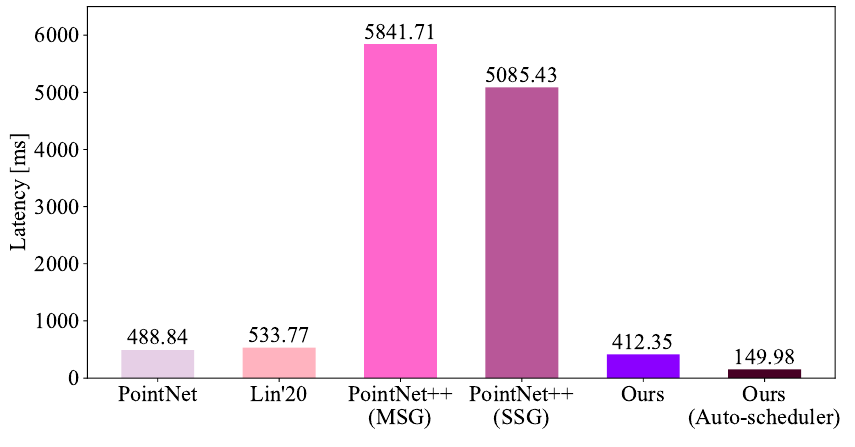
Figure 15. Comparison of latency on the UP Board CPU. Evaluating the latency under different tuning times: We present the latency of the optimized EffNet under different tuning times, as depicted in Figure 16. The latency changes with the number of trials on the UP Board CPU, Nano CPU, Nano GPU, TX2 CPU, TX2 GPU, and RTX GPU. In the figure, the abscissa shows the number of trials. The ordinate presents the latency. The inputs of all models were 1000 point cloud points. The dimension of each point was three. On the UP Board CPU, Nano CPU, and TX2 CPU, the latency decreases as the number of trials increases. On the Nano GPU, TX2 GPU, and RTX GPU, when the number of trials is less than 4000, the latency reduces with increasing tuning times; when tuning times exceed 4000, the latency decreases slowly as tuning times increase. When tuning times reach 10,000, the latency is lower than that under other